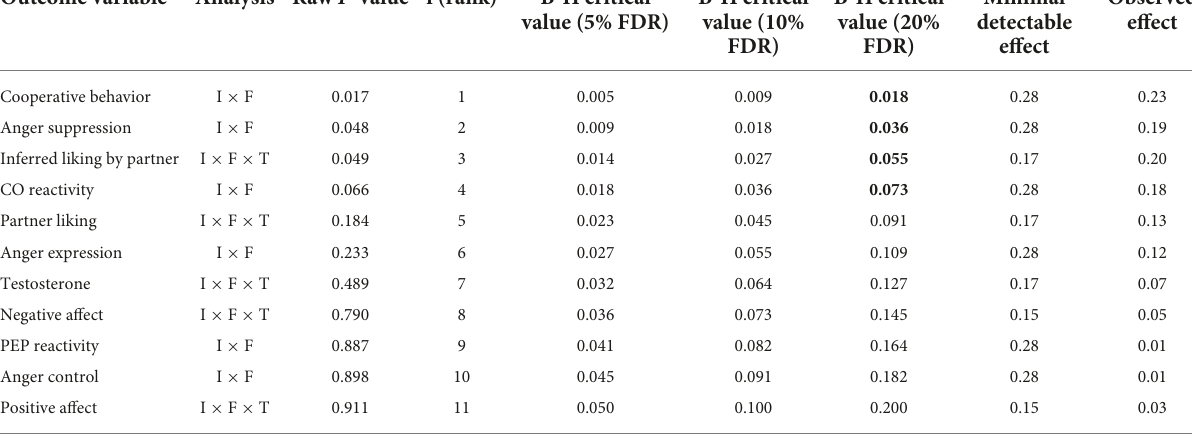
TABLE 3 Descriptive statistics for robustness